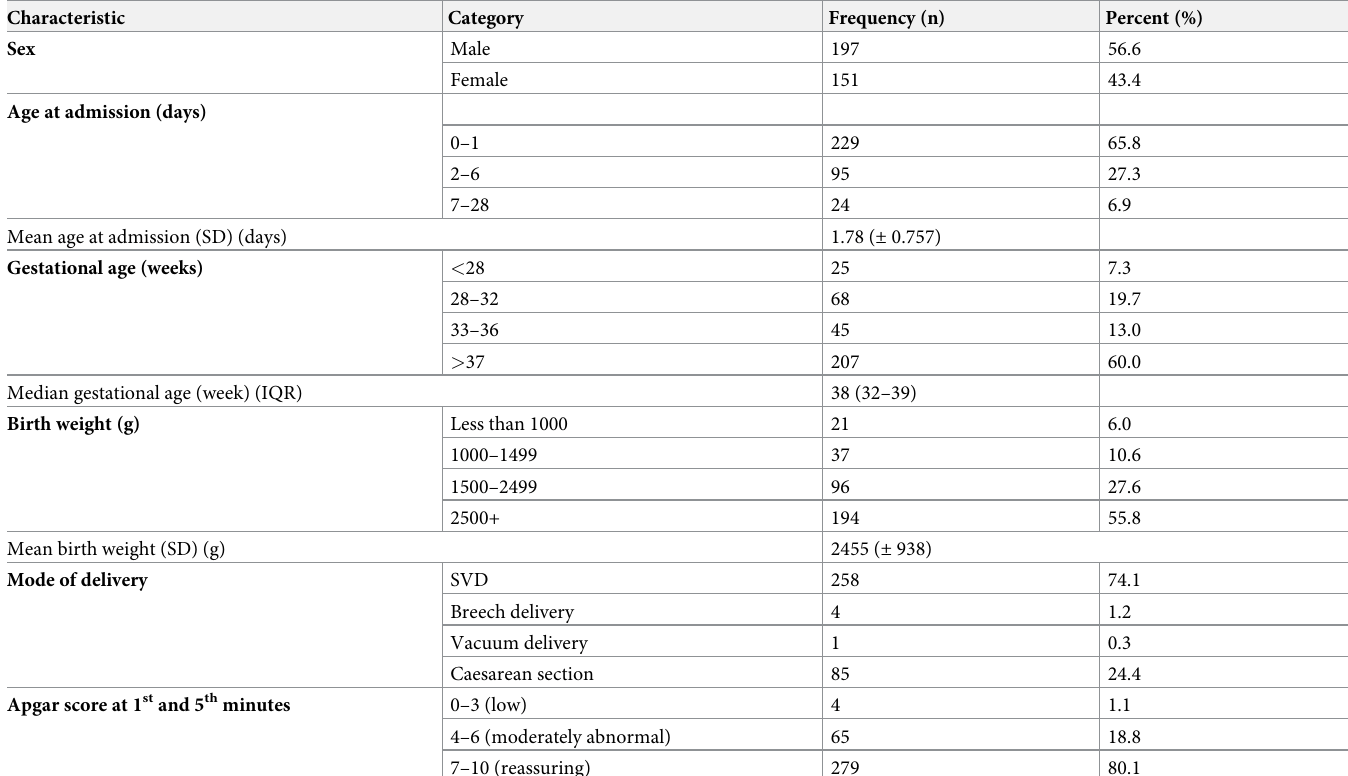
Table 1. Socio-demographic and clinical characteristics of study participants, N =